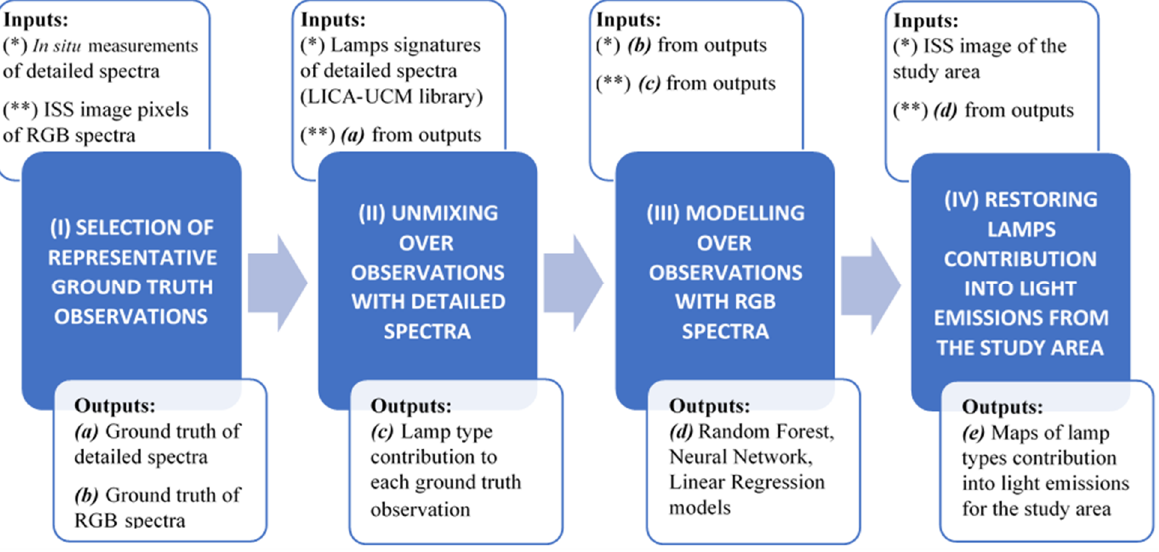
Figure 1. Methodological scheme of the study.